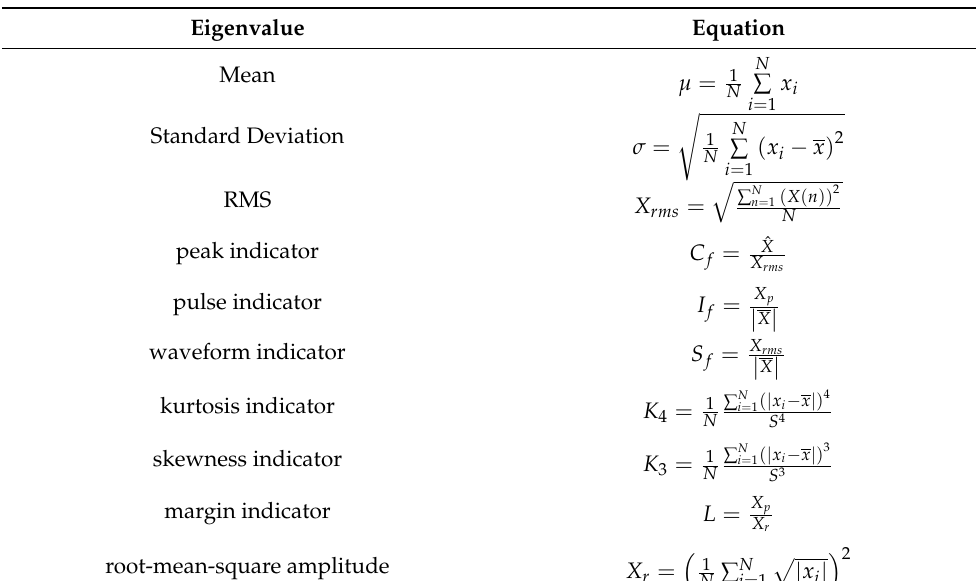
Table 2. Time domain